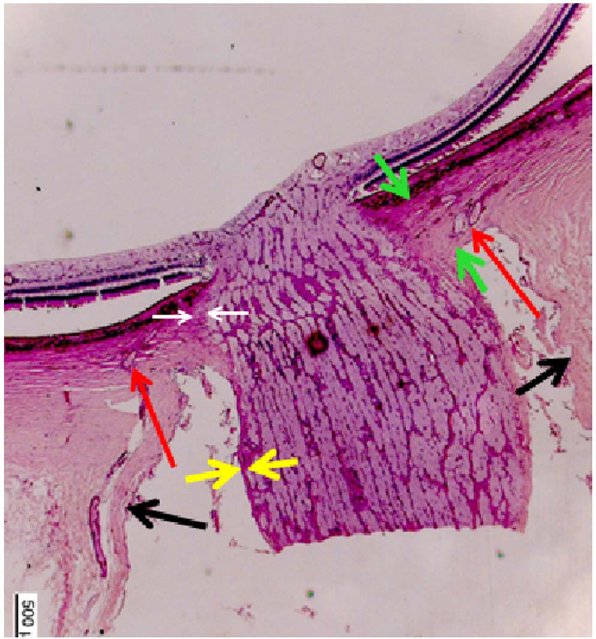
Figure 1. Histophotograph showing the optic nerve head of a non-highly myopic eyes with the peripapillary arterial circle of Zinn-Haller (red arrows), located at the merging point of the dura mater (black arrows) with the scleral at the end of the peripapillary scleral flange (between green arrows), the pia mater (yellow arrows), and the peripapillary ring (white arrows).